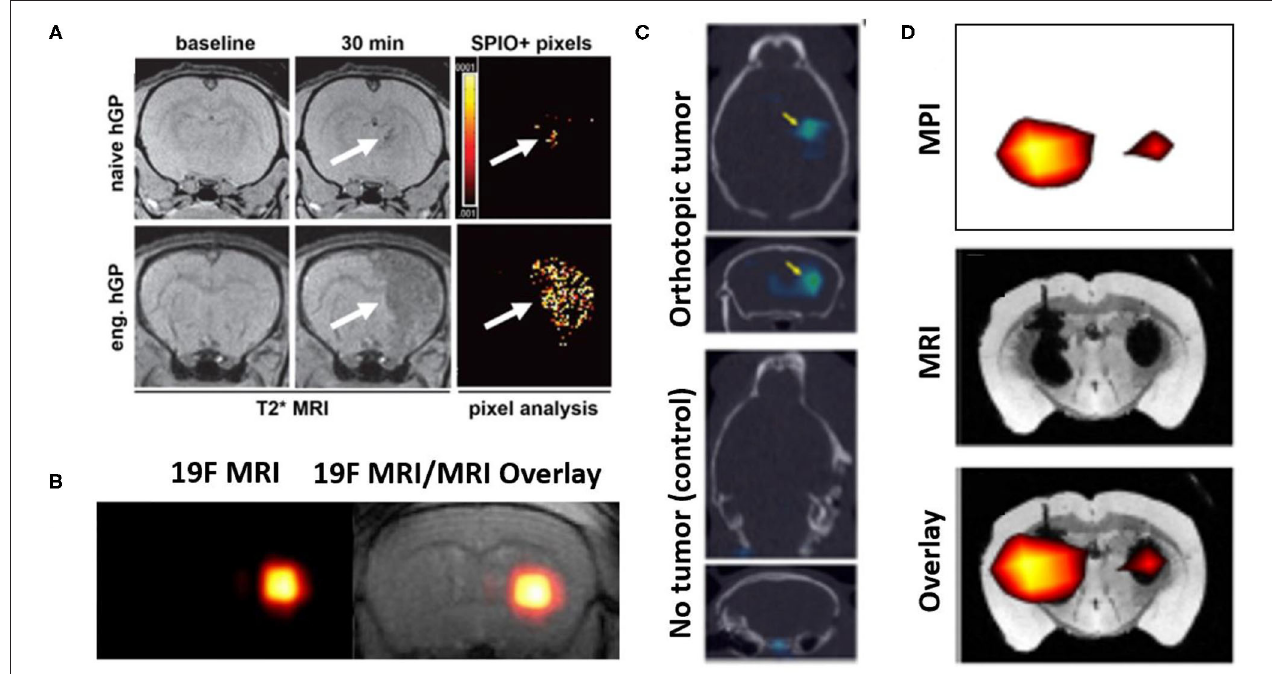
FIGURE 5 | Representative examples of image-based cell tracking methods in the brain. (A) T2* MR images of rat brains with experimentally induced inflammation and infused with SPION-labeled human glial precursor cells (hGP). At 30min. post-infusion, greater numbers of targeted (eng.) cells are observed in the inflamed tissue compared to naïve cells (arrows, hypointense signal). The results are supported by pixel-by-pixel analysis, comparing pre- and post-infusion MR images, which can be quantitatively compared. Modified, with permission, from “ Gorelik et al. Use of MR cell tracking to evaluate targeting of glial precursor cells to inflammatory tissue by exploiting the very late antigen-4 docking receptor. Radiology 2012; 265: 175-185” (105). (B) (left) 19F MRI and (right) 19F MRI & T2 weighted MR images of fluorine-19 labeled glial progenitor cells injected into a mouse brain striatum. “Hot spot” in each image is clearly identified, indicating the presence of the labeled cells. Figure adapted from Richard et al. Stem Cells Translational Medicine 2019. Reprinted under creative commons license (106). (C) SPECT signals (arrows) from 111-In labeled NSCs administered into control mice (lower) and those with a glioma model (upper), to which the cells have homed. In both panels, SPECT images are overlayed on CT scans. Figure adapted from Cheng et al. 2016 ( 107). This research was originally published in the Journal of Nuclear Medicine. (D) MPI imaging of SPION labeled MSCs in the left hemisphere (1 × 10 5 cells) and right hemisphere (5 × 10 4 cells) transplanted in a mouse brain. Lower panel shows MPI signals (upper panel) superimposed on T2* MR image (middle panel). Figure adapted from Bulte et al. Tomography 2015 ( 108). Reprinted under creative commons